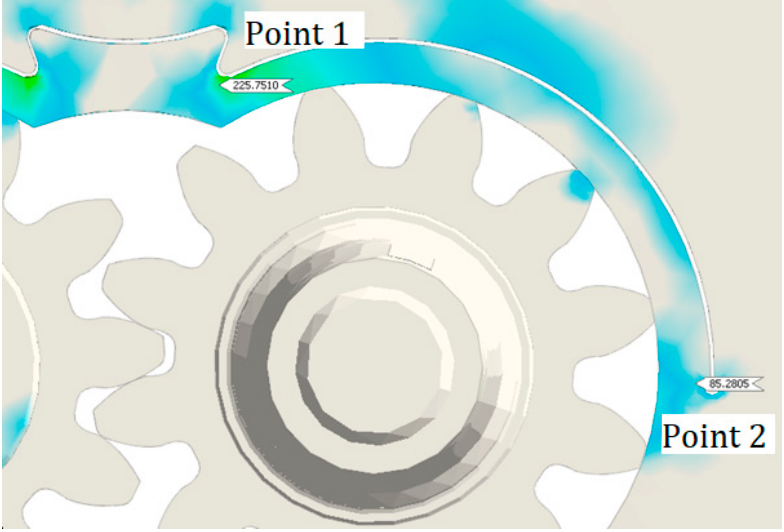
Figure 11. Locations of the points used in the analysis of stresses in the area of the integrated lip.